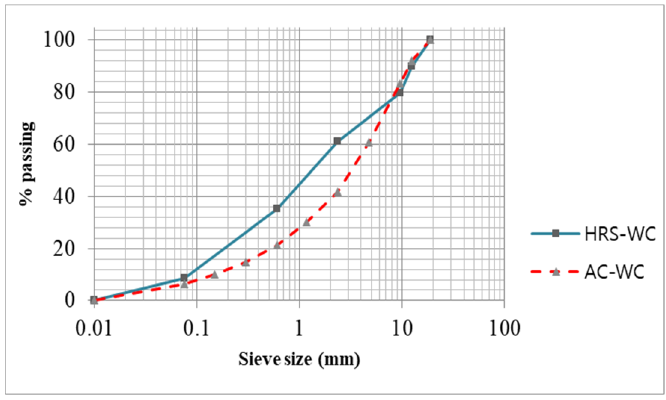
Figure 1. Aggregate gradations for AC-WC and HRS-WC mixtures.